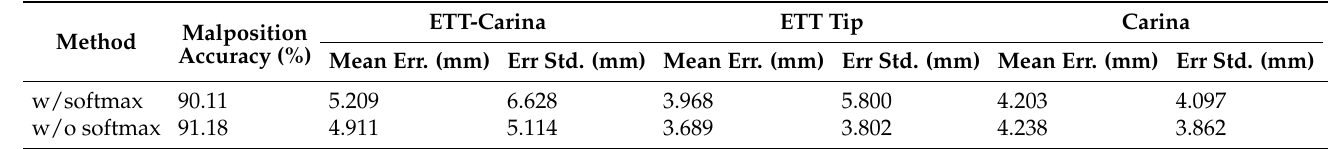
Table 15. The effect of softmax in GA.